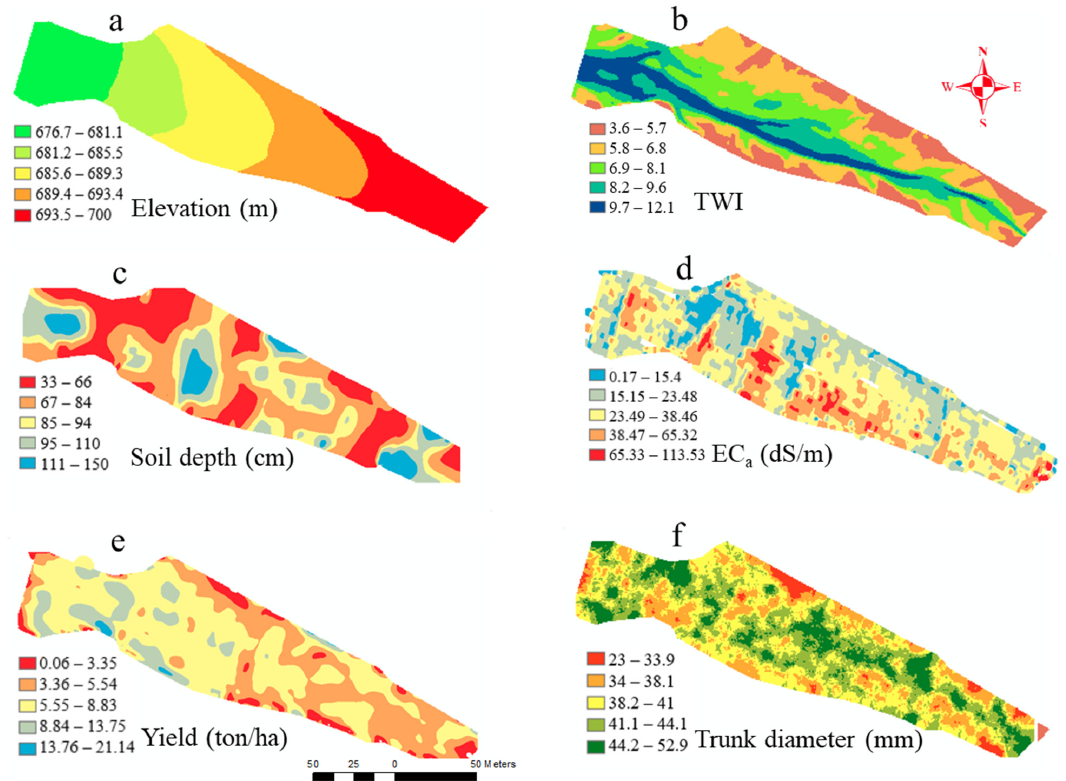
Figure 2. Spatial maps of ( a ) elevation (masl), ( b ) topographic wetness index (TWI), ( c ) soil depth (cm), ( d ) apparent electrical conductivity (EC a ) at 0–75 cm depth, ( e ) yield from 2017 (ton/ha) and ( f ) trunk diameter (mm).